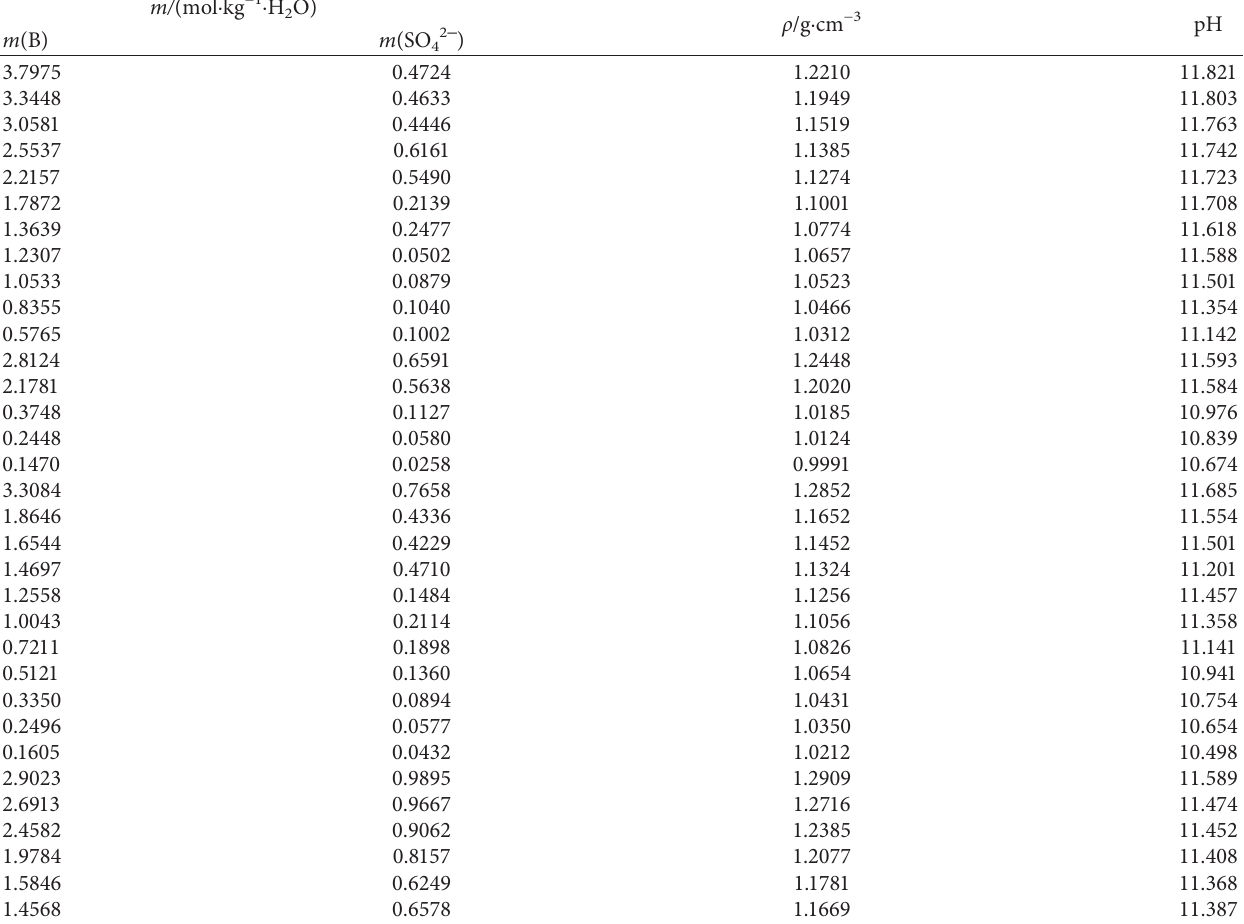
2 –Na 2 SO 4 –H 2 O at